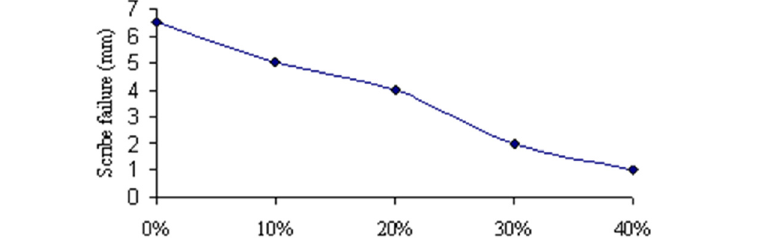
Figure 5: Scribe failure resistance of modi fi ed alkyd primer